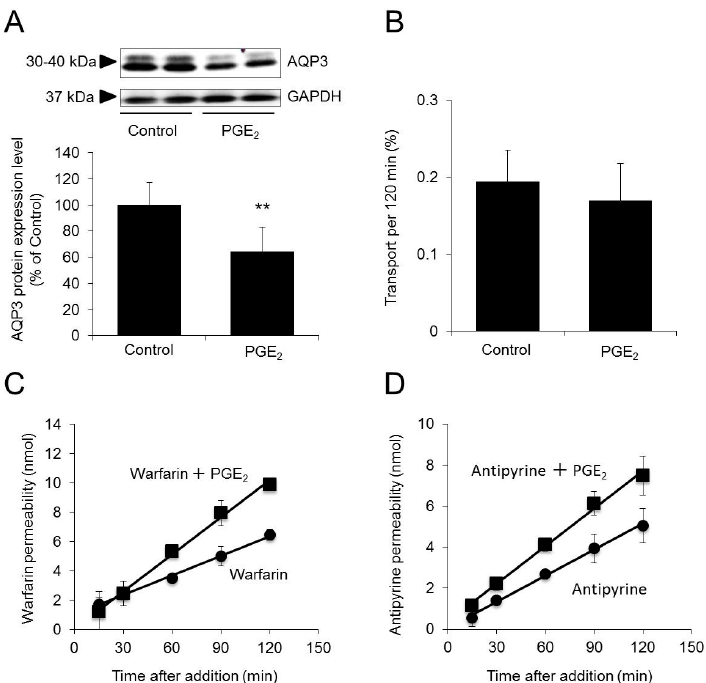
Figure 4. Effect of decreased AQP3 expression on permeability to warfarin/antipyrine. Caco-2 cells were plated in Transwell plates and incubated for 21 days. ( A ) Prostaglandin E 2 (PGE 2 ) was added to the apical side of the Transwell plate. At 1 h after treatment, the protein expression of AQP3 was analyzed by Western blotting and normalized to glyceraldehyde-3–phosphate dehydrogenase (GAPDH) expression. The mean levels of AQP3 protein expression in the control group were set as 100%. ( B ) Lucifer yellow alone or a combination of PGE 2 and lucifer yellow was added to the apical side of the Transwell plate. At 2 h after treatment, the concentration of lucifer yellow on the basal side was measured. ( C ) Warfarin alone or a combination of warfarin and PGE 2 was added to the apical side of the Transwell plate. The concentration of warfarin on the basal side was measured. ( D ) Antipyrine alone or a combination of antipyrine and PGE 2 was added to the apical side of the Transwell plate. The concentration of antipyrine on the basal side was measured. The data are presented as the mean ± SD for six experiments. Student’s t -test: ** p < 0.01 vs. the control value.